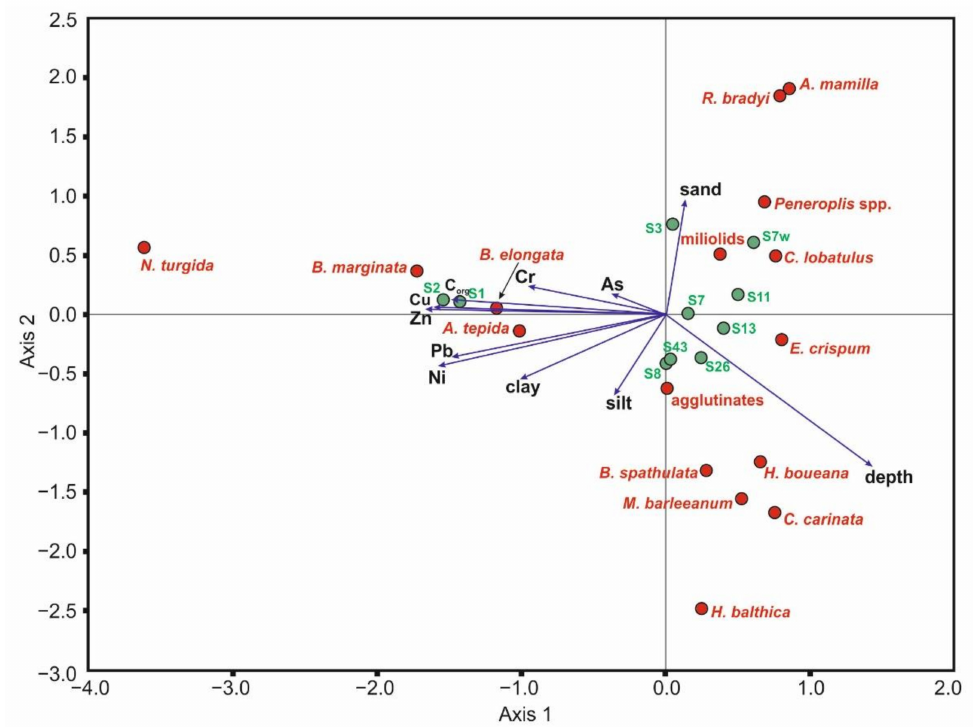
Figure 6. Canonical correspondence analysis (CCA) triplot of most abundant foraminiferal species (red points) and environmental parameters (blue vectors). Site scores are plotted as green